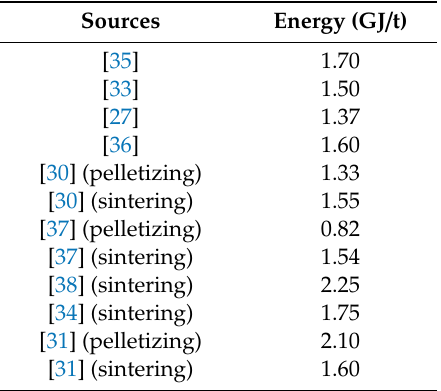
Table 6. Iron ore agglomeration per ton of iron ore agglomerated.